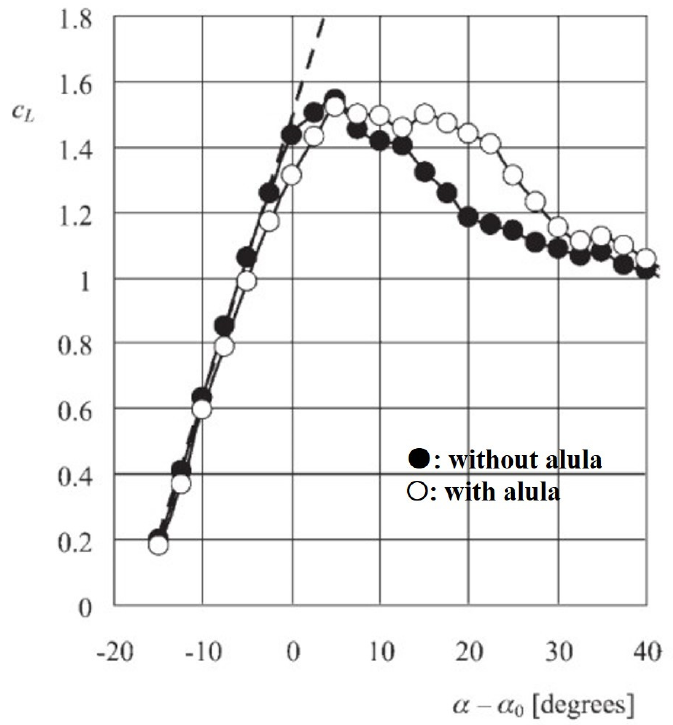
Figure 3. Variation in lift coefficient with the angle of attack for a pigeon wing model ( ● : without alula deployment; ⭕ : with alula deployment) [5].